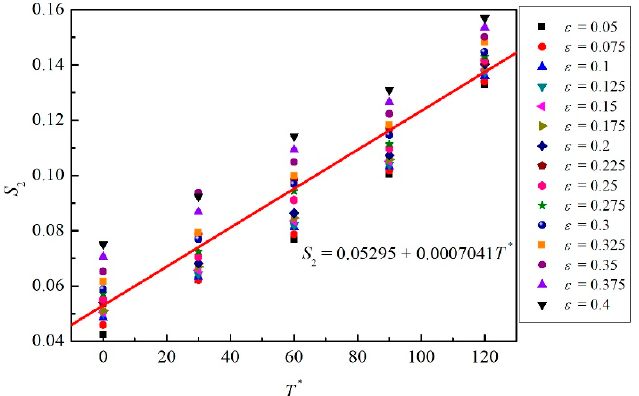
Figure 9. The relation between S 1 and ε .